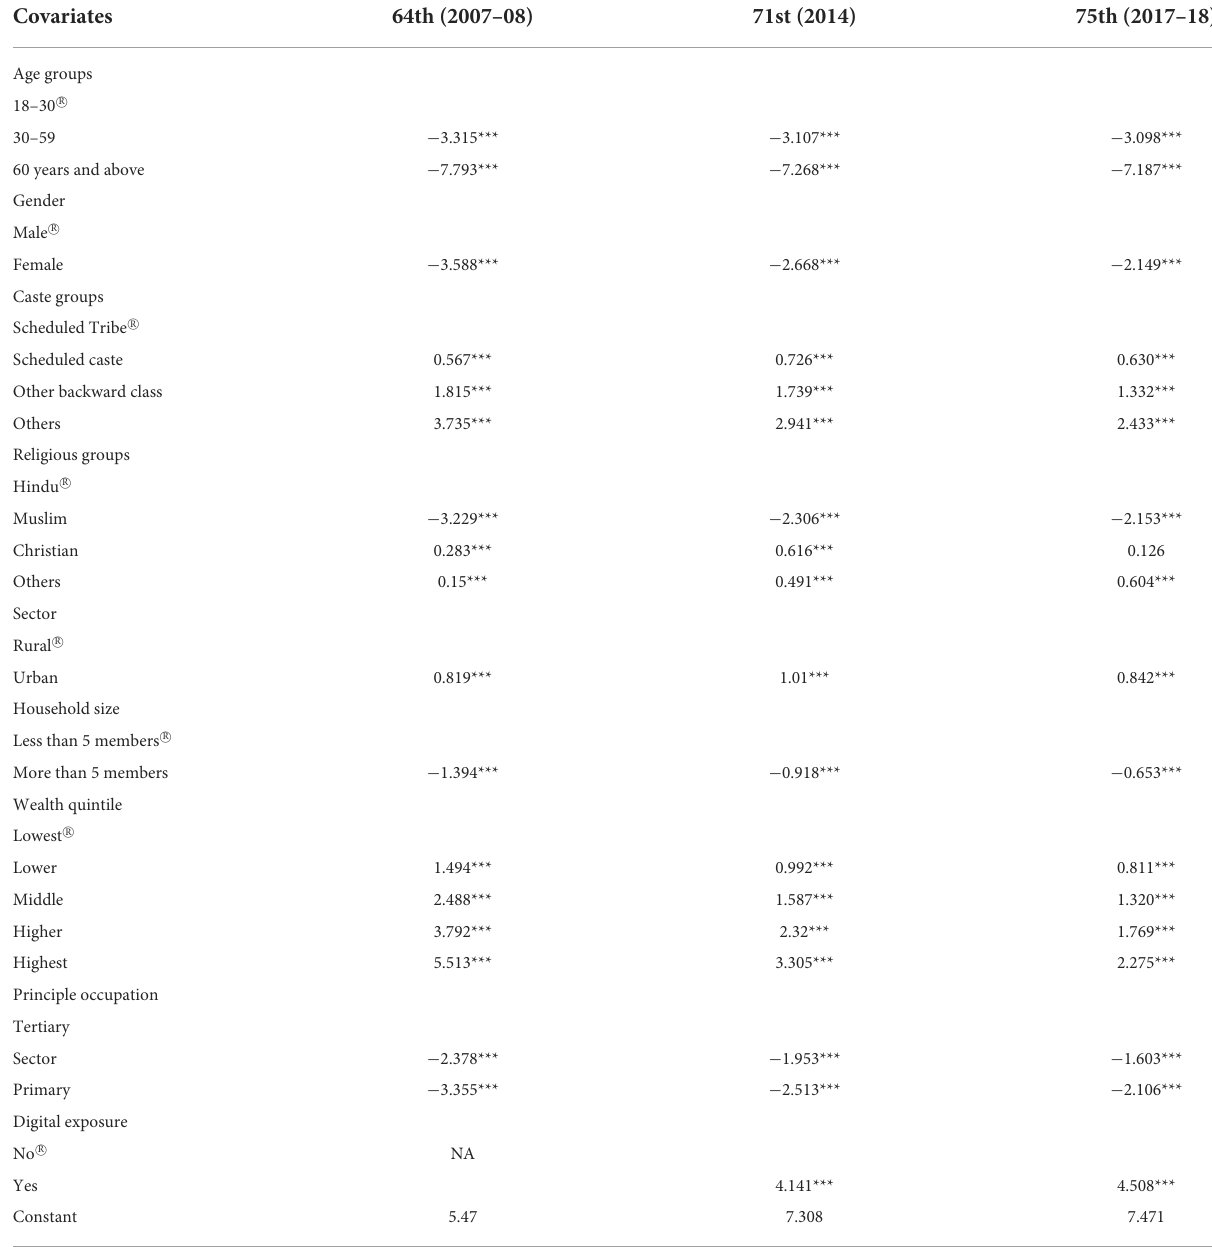
TABLE 4 Result of the Tobit model for average years of